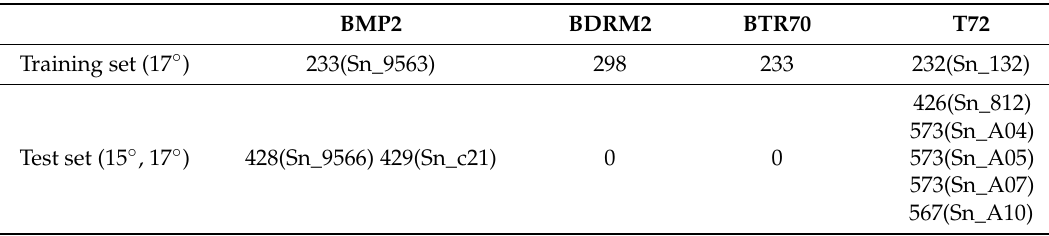
Table 7. Dataset for configuration variance test.